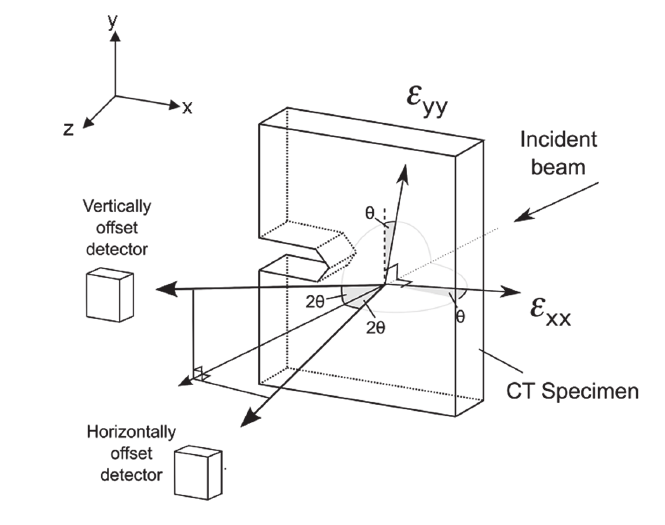
Figure 1: Illustration of beam and Compact Tension specimen